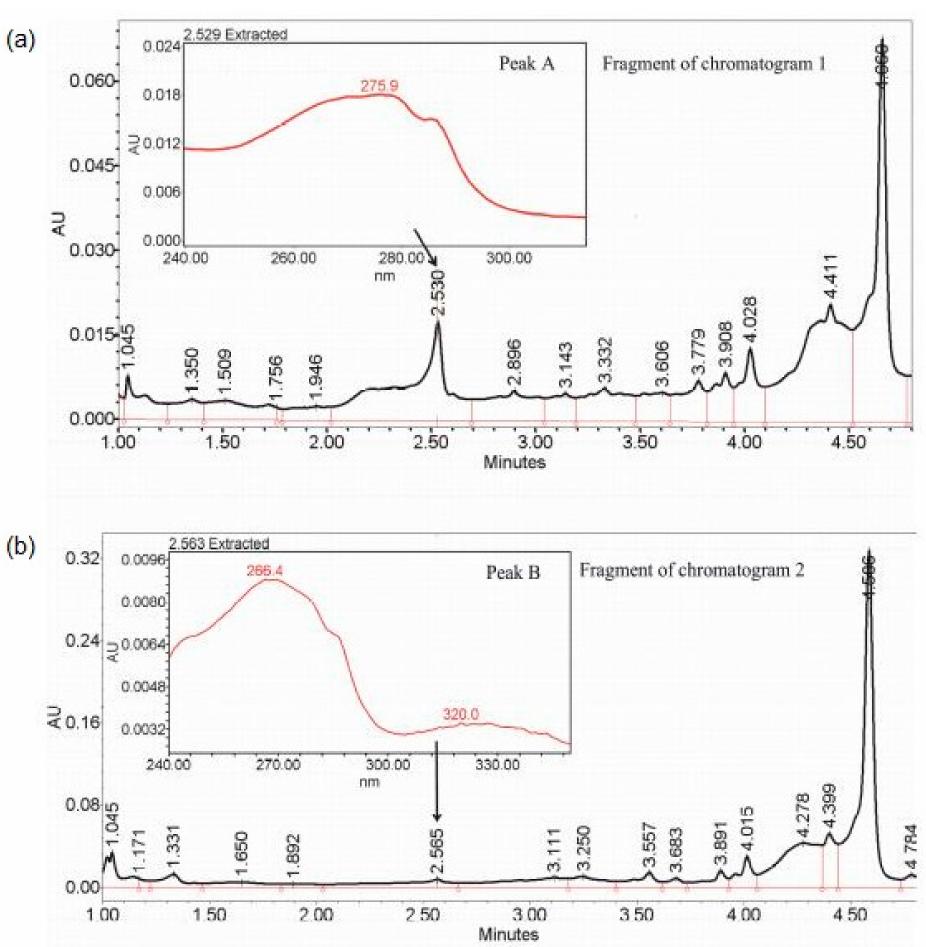
Figure 5. Fragments of: ( a ) chromatogram 1 and ( b ) chromatogram 2, belonging to different clusters, with peaks A and B (also shown in Figure 4b) corresponding to retention times of 2.530 and 2.564 min, respectively, and with highlighted maxima of absorption λ max = 275.9 nm in chromatogram 1 and λ max = 266.4 and 320 nm in chromatogram 2, indicating two different